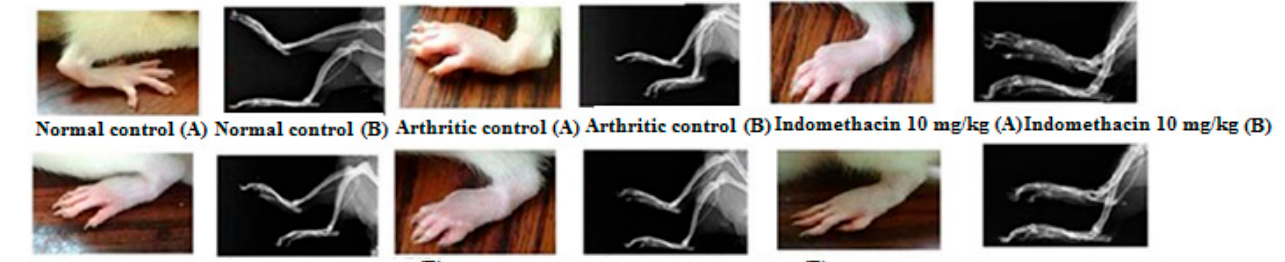
Figure 5. Photographic and radiographic analysis of FCA-induced arthritis in rats. ( A ) Photographic of the left hind paw taken 14 days after FCA injection and ( B ) radiographic analysis of the left and right hind paws at day 21 after FCA injection.